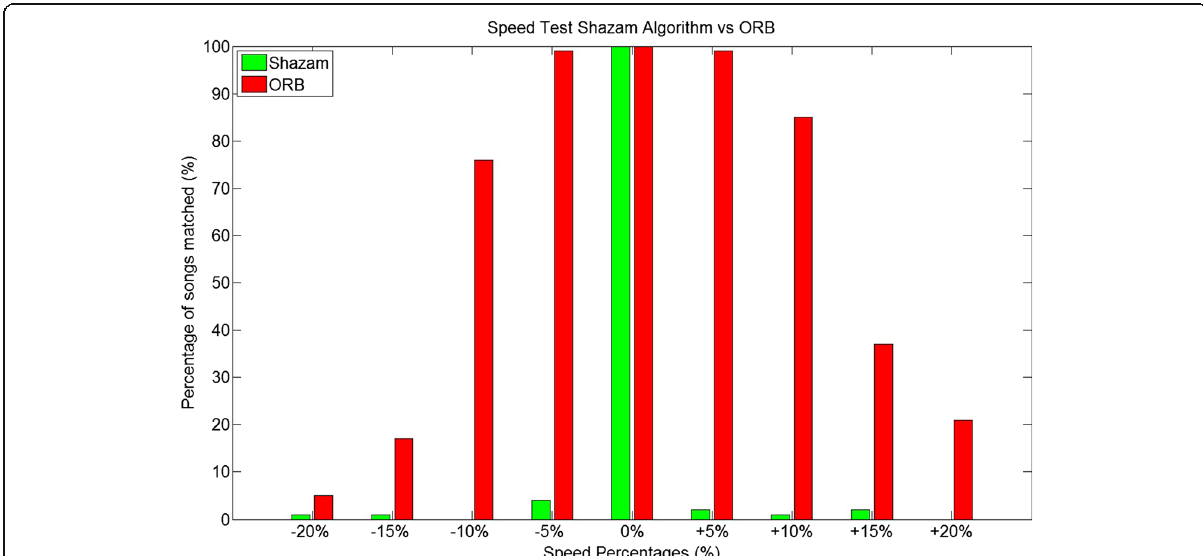
Fig. 3 Speed test for robustness (Shazam vs ORB). In this figure, the speed test was done for the range from − 20 to +20%. The both algorithms were compared to show the effects of the speed changes on the ability for the both systems to correctly identify the distorted samples. The speed is the combination of pitch and tempo distortion. It was seen that the ORB prototype produced better results compared to the Shazam